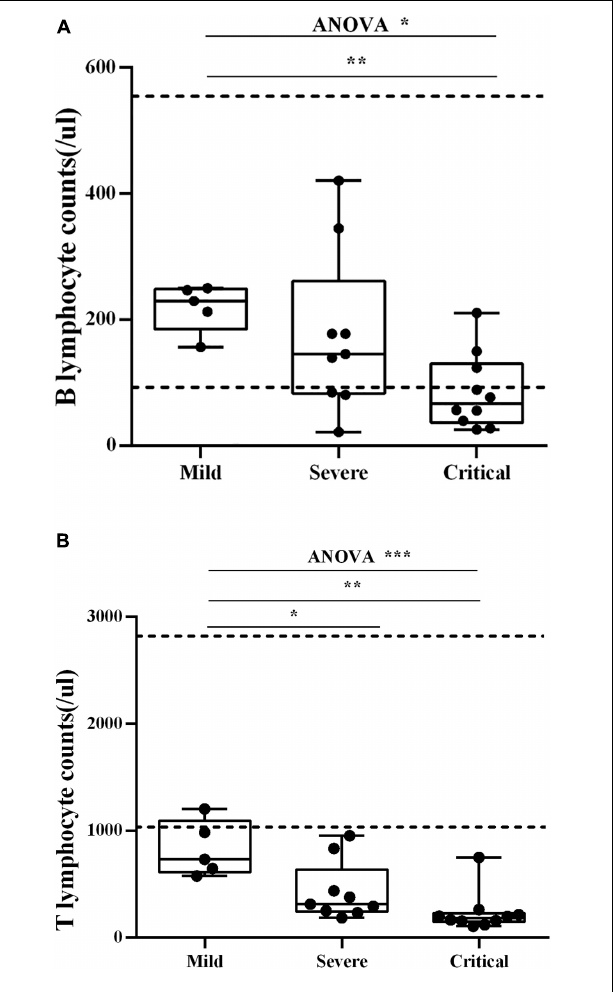
FIGURE 2 | (A) Blood B lymphocyte counts. Blood B lymphocyte counts were measured in three groups of patients. The dash lines indicate the standard clinical range for healthy people. Each dot corresponds to a sample from a single patient. * p < 0.05, ** p < 0.01. (B) Blood T lymphocyte counts. Blood T lymphocyte counts were measured in three groups of patients. The dash lines indicate the standard clinical range for healthy people. Each dot corresponds to a sample from a single patient. * p < 0.05, ** p < 0.01, *** p < 0.001.